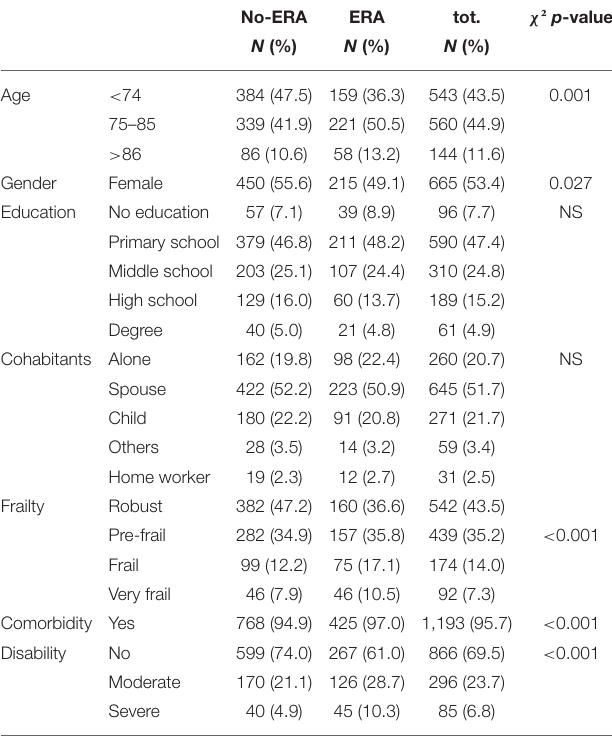
TABLE 1 | Sociodemographic characteristics of the sample ( N = 1,247). No-ERA ERA